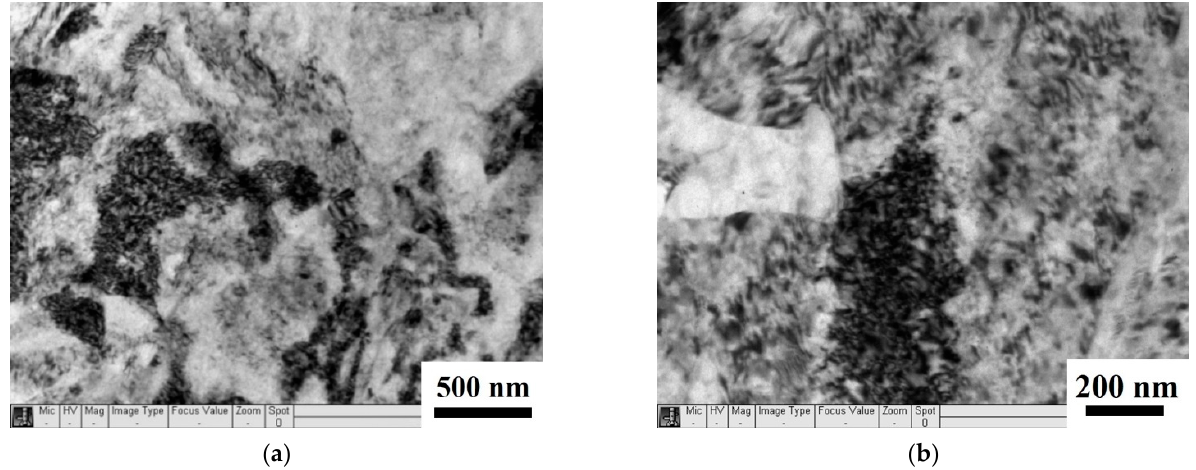
Figure 6. Microstructure of the near ‐ surface layer of a Ti ‐ 6Al ‐ 4V sample with UFG structure after PEP: general view of the inhomogeneous structure ( a ); pile ‐ ups of dislocations ( b ). TEM.